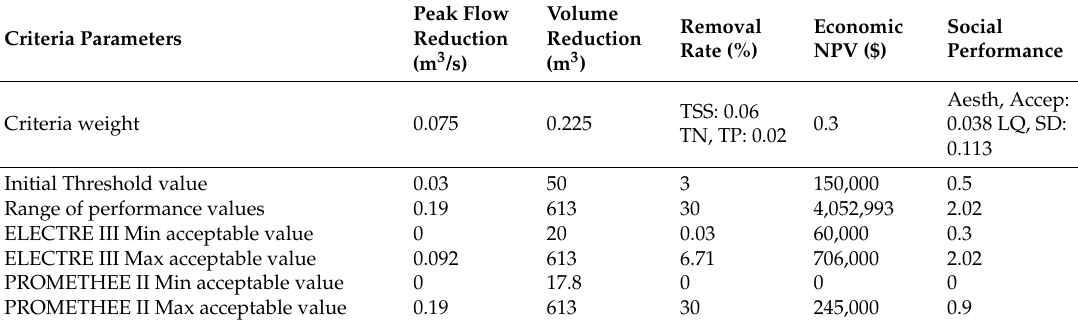
Table 16. Elimination et Choix Traduisant la Réaité (ELECTRE) III and Preference Ranking Organization Method for Enrichment of Evaluation (PROMETHEE) II threshold sensitivity